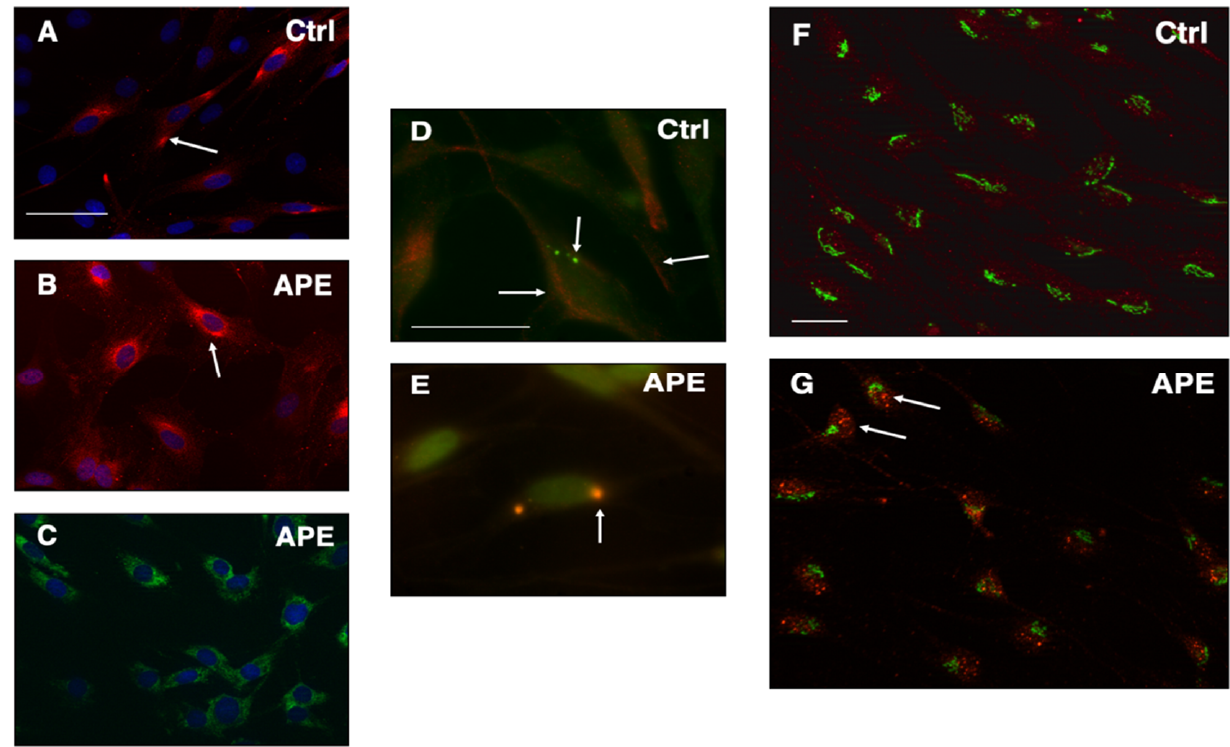
Figure 4. Immunocytochemistry analysis of ErbB2 expression upon M2 agonist treatment. Immunostaining for erbB2 receptors (red staining) in untreated ( A ) and APE treated SCs ( B ). The arrows indicate the different localization of erbB2 receptors. In ( C ) is shown the immunostaining for BIP (green staining), a typical ER marker (scale bar = 150 µm). The localization of erbB2 receptors changes after M2 agonist stimulation, resulting mainly in perinuclear regions of the cells. ( D , E ) Co-immunostaining for erbB2 (red staining) and Lamp-1 (green staining), marker of lysosome, or ( F , G ) GM-130 (green staining), marker of Golgi apparatus. The immunostaining clearly demonstrates that erbB2 receptors co-localize with Lamp-1, (E; scale bar = 50 µm), but not with the Golgi marker, after M2 agonist treatment ( G ), (scale bar = 100 µm). The arrows in G indicate the red spots expressing erbB2 receptors in APE treated cells that may be lysosomes/endosomes.